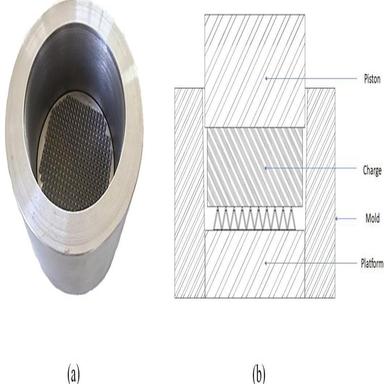
a) Platform placed at the bottom of the mold b) pressing section.